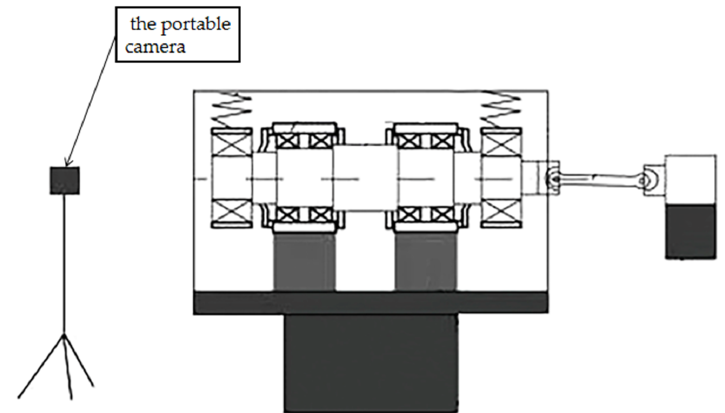
Figure 6. Displacement video capture scheme.